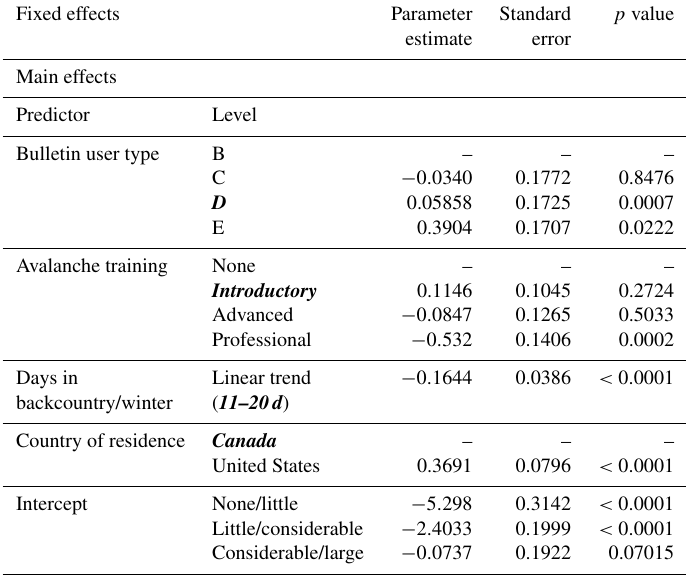
Table B1. Parameter estimates of regression model examining the attention paid to the TTA statements (number of obs.: 2998; observations). Bolded and italicized levels are used to calculate the estimated marginal probabilities for the post hoc tests.